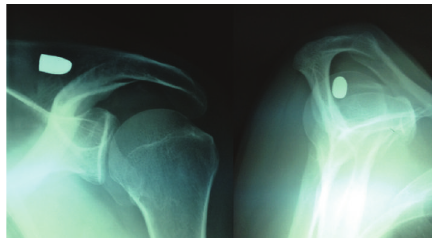
Figure 1: Preoperative anteroposterior and axial radiographs showing the bullet in the supraspinatus compartment of the shoulder.